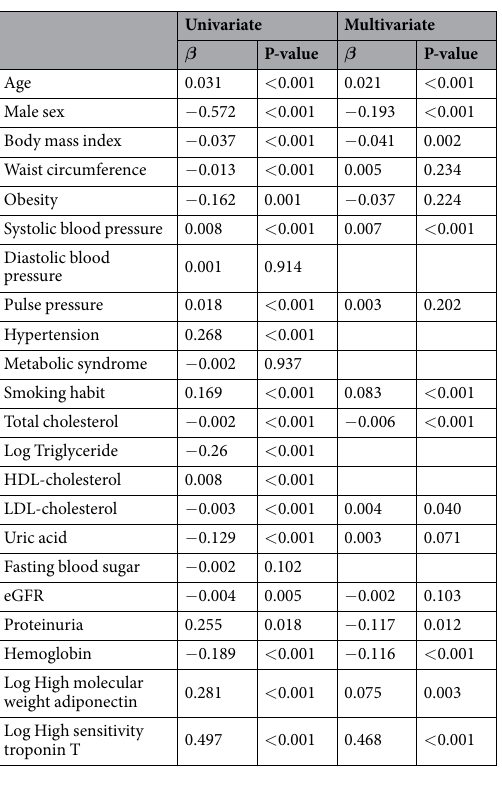
Table 3. Factors correlated with log NT-proBNP by adjusted regression analysis. N = 2140. After the forward stepwise procedure for selection of variables, multivariable regression analysis was performed adjusted for age, sex, BMI, waist circumference, obesity, systolic blood pressure, pulse pressure, smoking habit, total cholesterol, LDL-cholesterol, uric acid, eGFR, proteinuria, hemoglobin, logarithmic HMW-adiponectin and logarithmic hsTnT. Abbreviations, see Table 1.